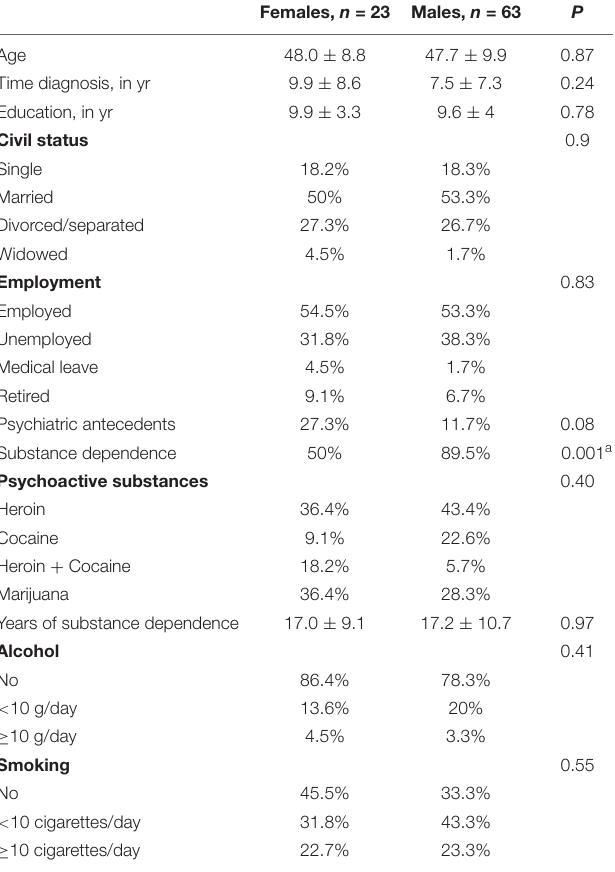
TABLE 1 | Demographic and personal characterization with gender comparison.